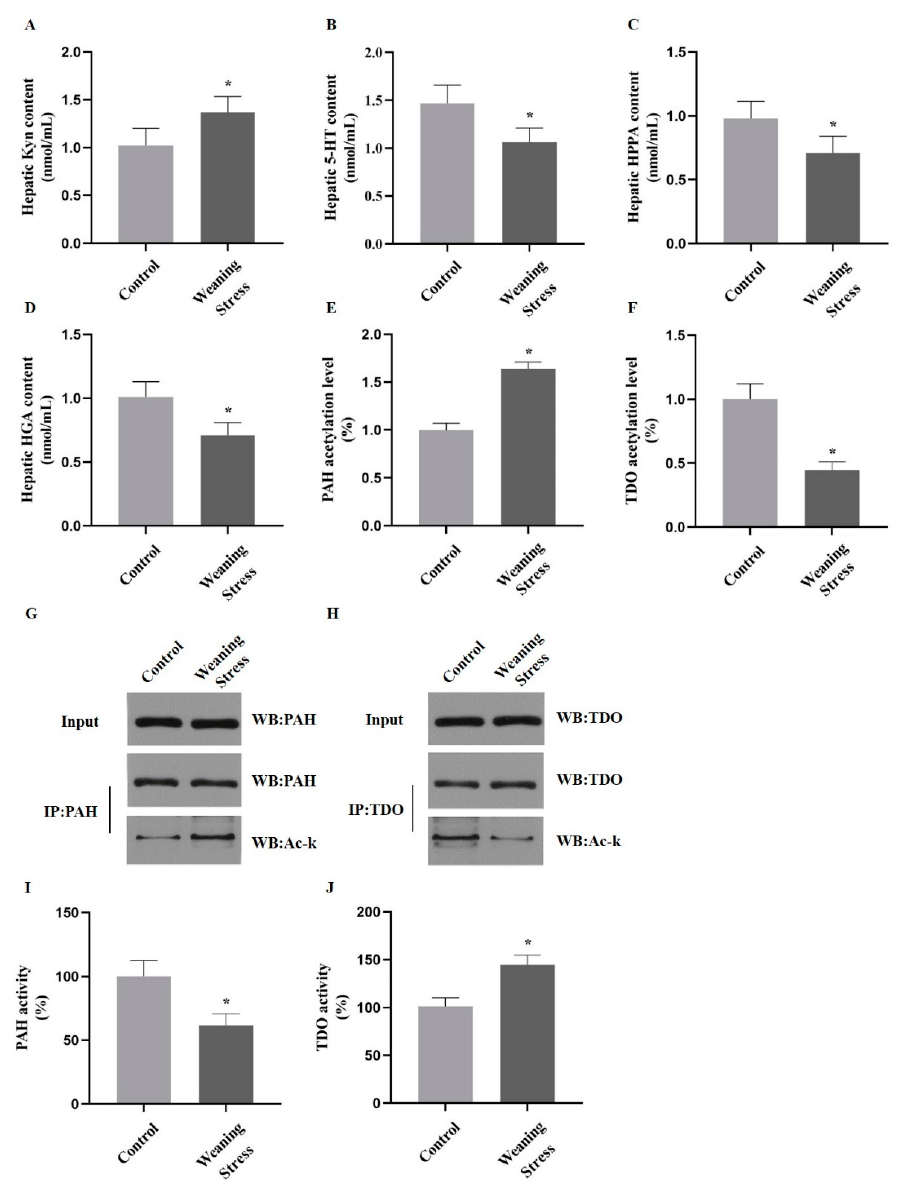
Figure 5. Acetylation of PAH inhibits phenylalanine catabolism and acetylation of TDO promotes tryptophan catabolism in primary hepatocytes. ( A – D ) The content of Kyn, 5-HT, HPPA, and HGA (nmol / mL) in primary porcine hepatocytes from liver of weaned piglets. ( E – H ) PAH and